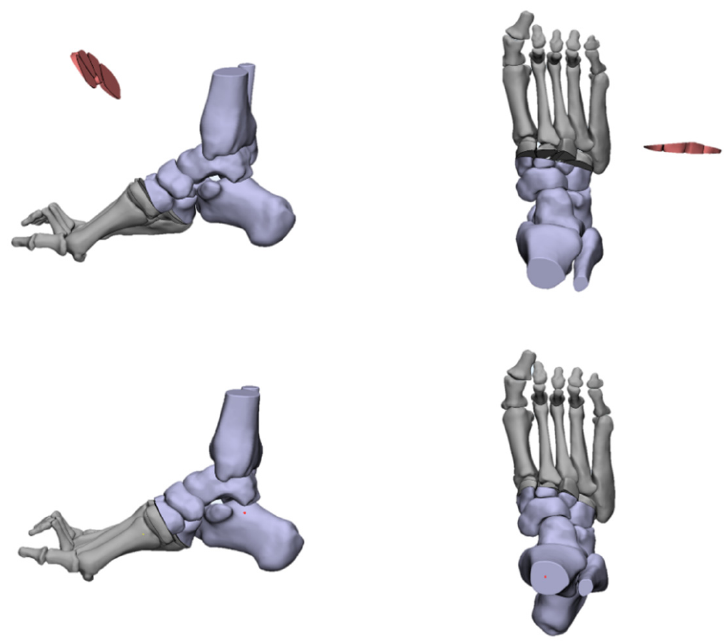
Figure 14. The Myerson Osteotomy.